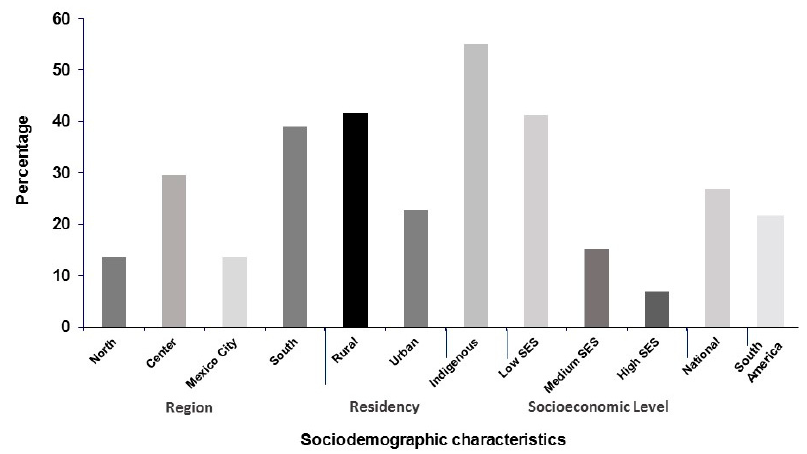
Figure 2. Prevalence of stunting in children <5 years in Mexico in 1988. Adapted from a published source [9], N = 7246 children <5 years, National Nutrition Survey 1988.